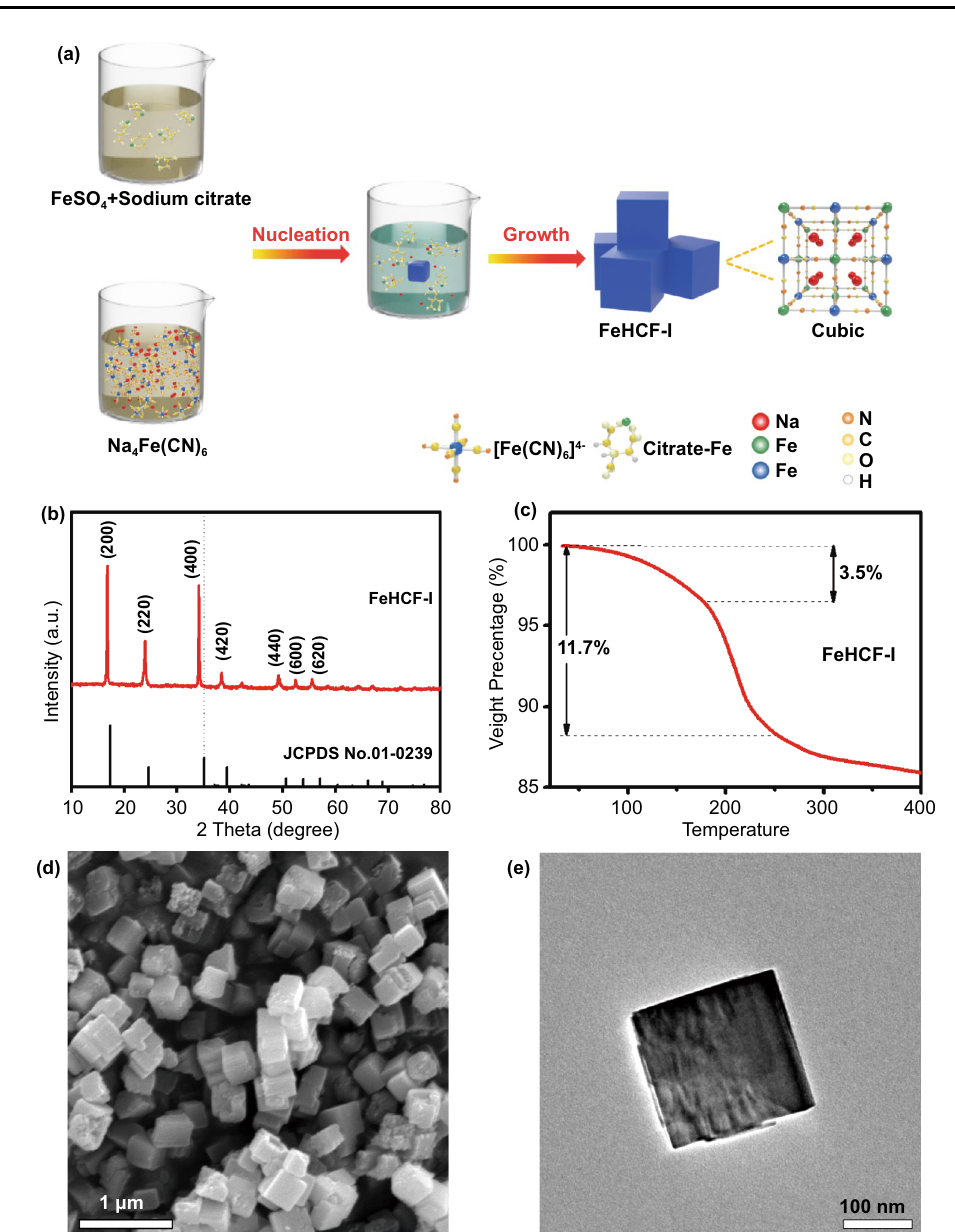
Fig. 4 a Schematic illustration of the synthetic procedure of FeHCF-I. b XRD pattern. c TG curve. d SEM image and e TEM image of